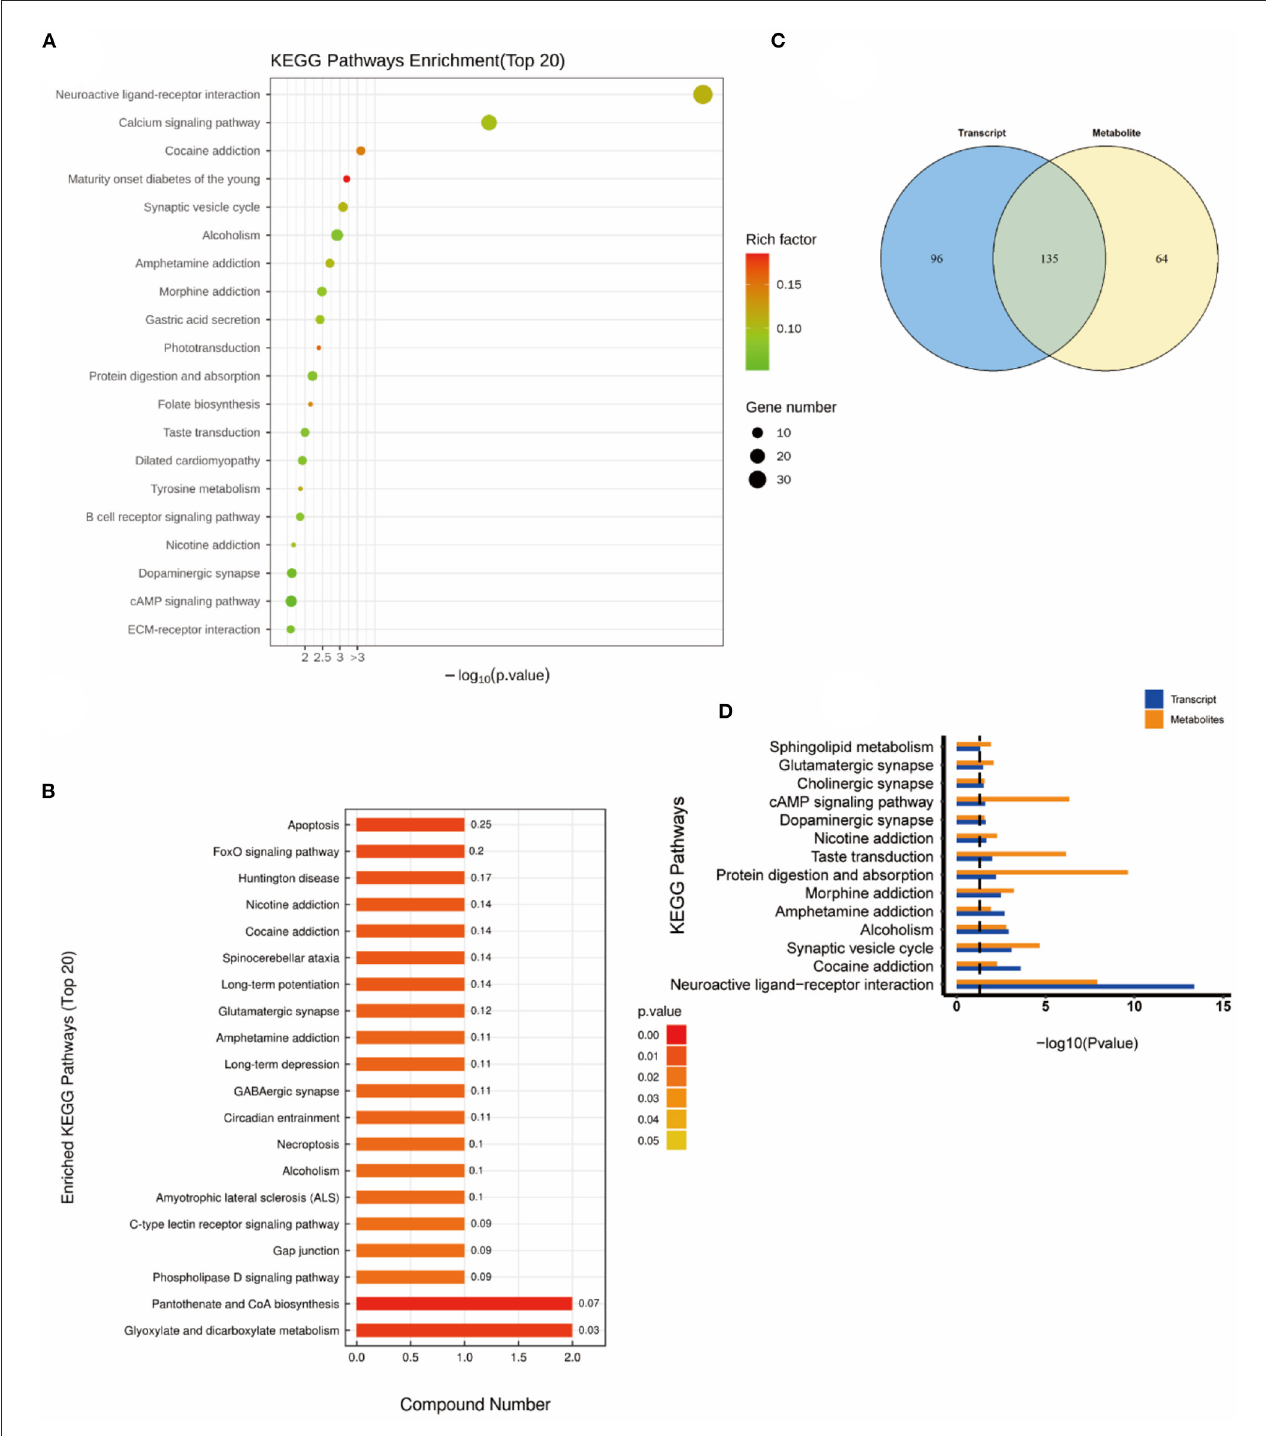
FIGURE6 KEGG pathway analyses of DEGs and DMs identified by comparing the H 2 group and the control group. (A) KEGG pathway analyses of DEGs. (B) KEGG pathway analyses of DMs. (C) Venn diagram of the KEGG pathway involving DEGs and DMs. (D) Enrichment analysis of KEGG pathway between DEGs and DMs. N =